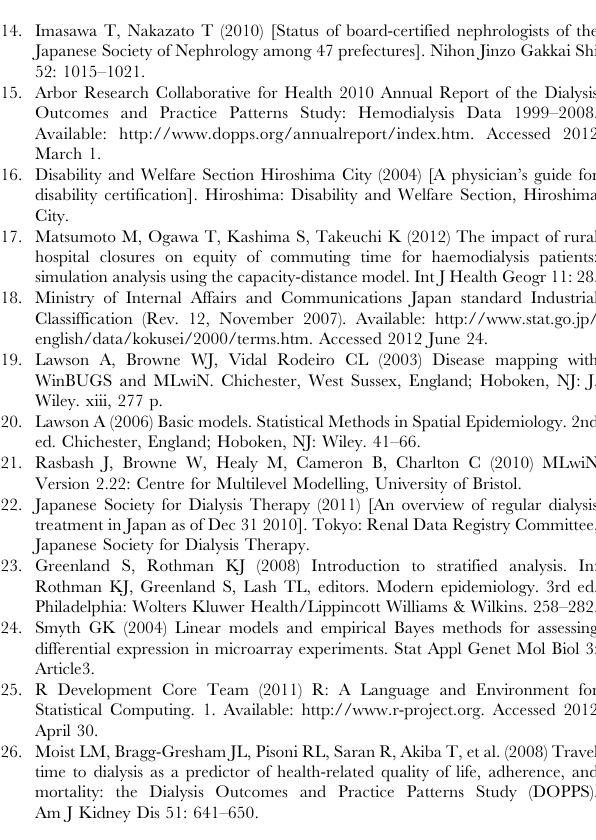
Figure S1 Predicted age- and sex-adjusted standard prevalence rates by land type in capacity-distance